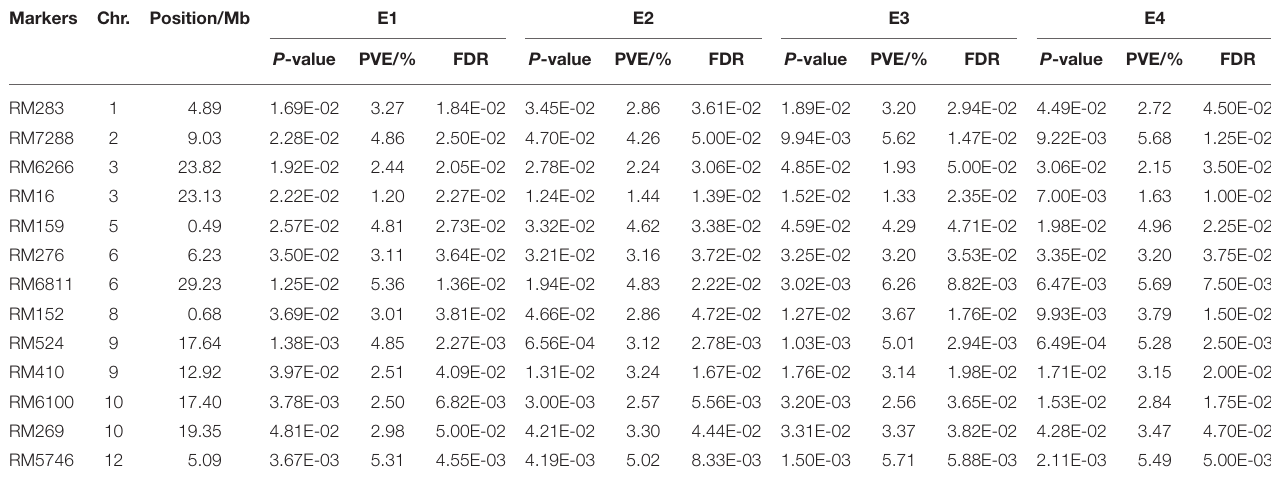
TABLE 4 | Marker associated with PEL at P -values < 0.05, their equivalent false discovery rate probability (FDR), proportion of PVE, and marker position on chromosome derived from 262 markers and 483 rice accessions. Markers Chr.